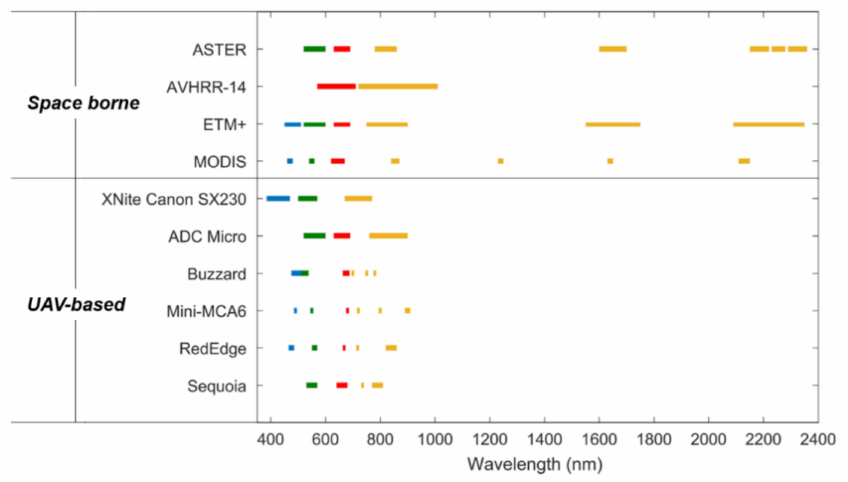
Figure 1. Spectral bands of commonly used spaceborne and UAV-based multispectral sensors /